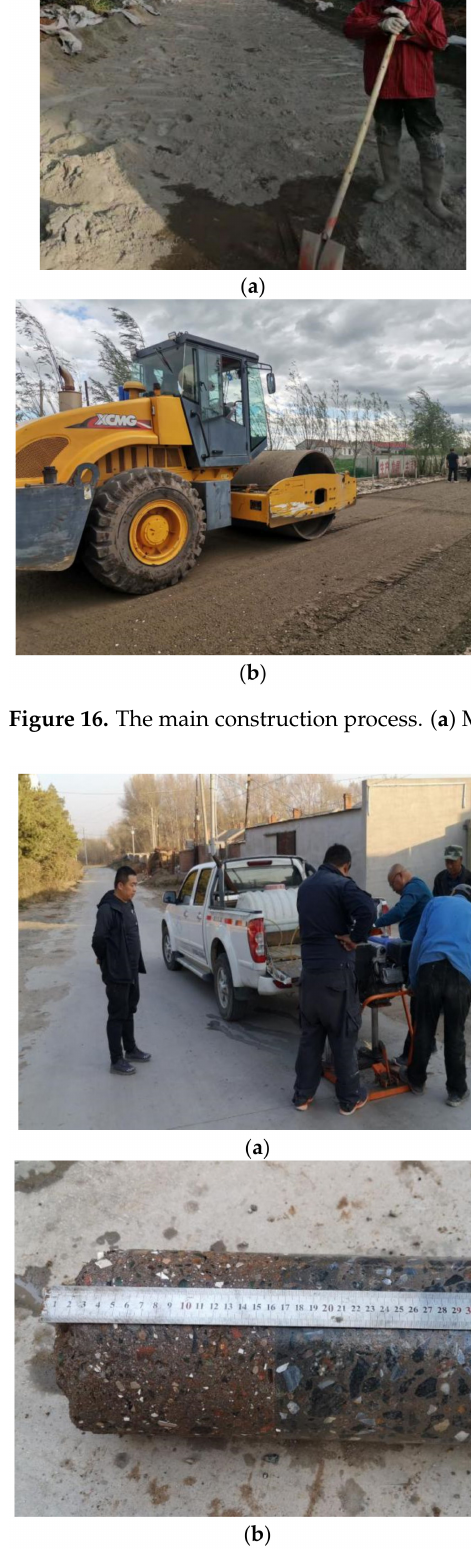
Figure 17. Drill core sampling. ( a ) Sampling. ( b ) Core